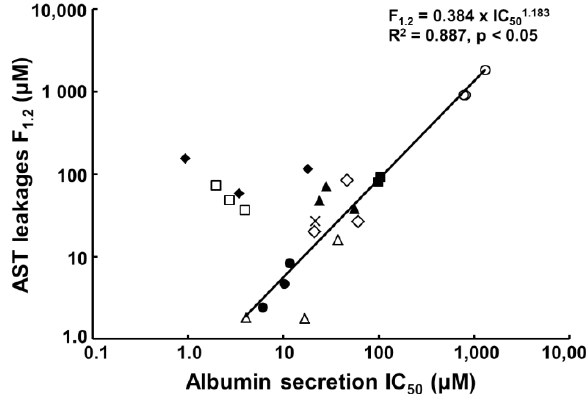
Figure 4. Correlation between albumin secretion (IC 50 ) and aspartate aminotransferase (AST) leakage (F 1.2 ) in toxicity evaluation of compounds with PHH spheroids. The IC 50 values and F 1.2 values of acetaminophen (open circles), chlorpromazine (closed circles), cyclosporine A (open squares), diclofenac (closed squares), fialuridine (closed rhombuses), flutamide (open rhombuses), imipramine (open triangles), ticlopidine (closed triangles), and troglitazone (cross marks) are shown. There is a strong positive correlation, except for cyclosporine A and fialuridine. Reprinted from reference [53].